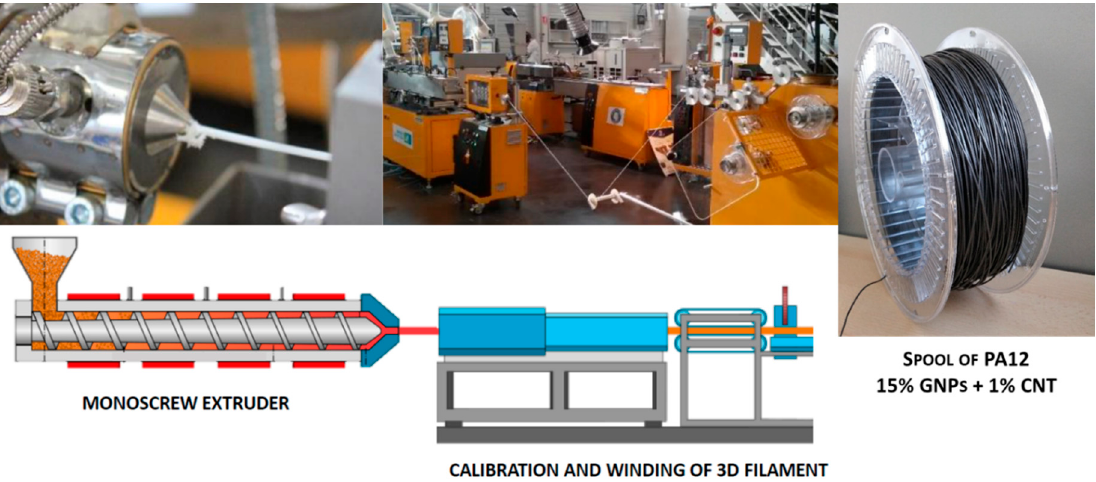
Figure 1. 3D printing fillers produced by a single-screw extruder combined with a filament shaper. Table 1. Technical data of the PA12_15%GNPs + 1%CNTs filament.